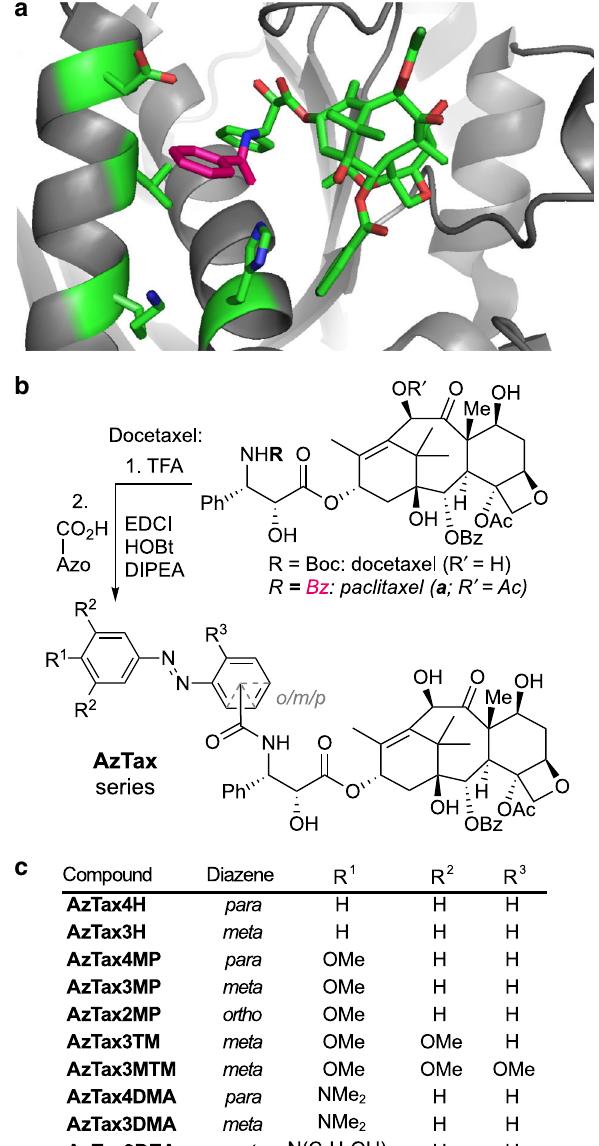
Fig. 1 Design and synthesis of AzTax. a Paclitaxel:tubulin structure (PDB: 3J6G 36 ) with the benzamide indicated in pink. b Synthesis of AzTax from docetaxel. c Panel of AzTax examined in this